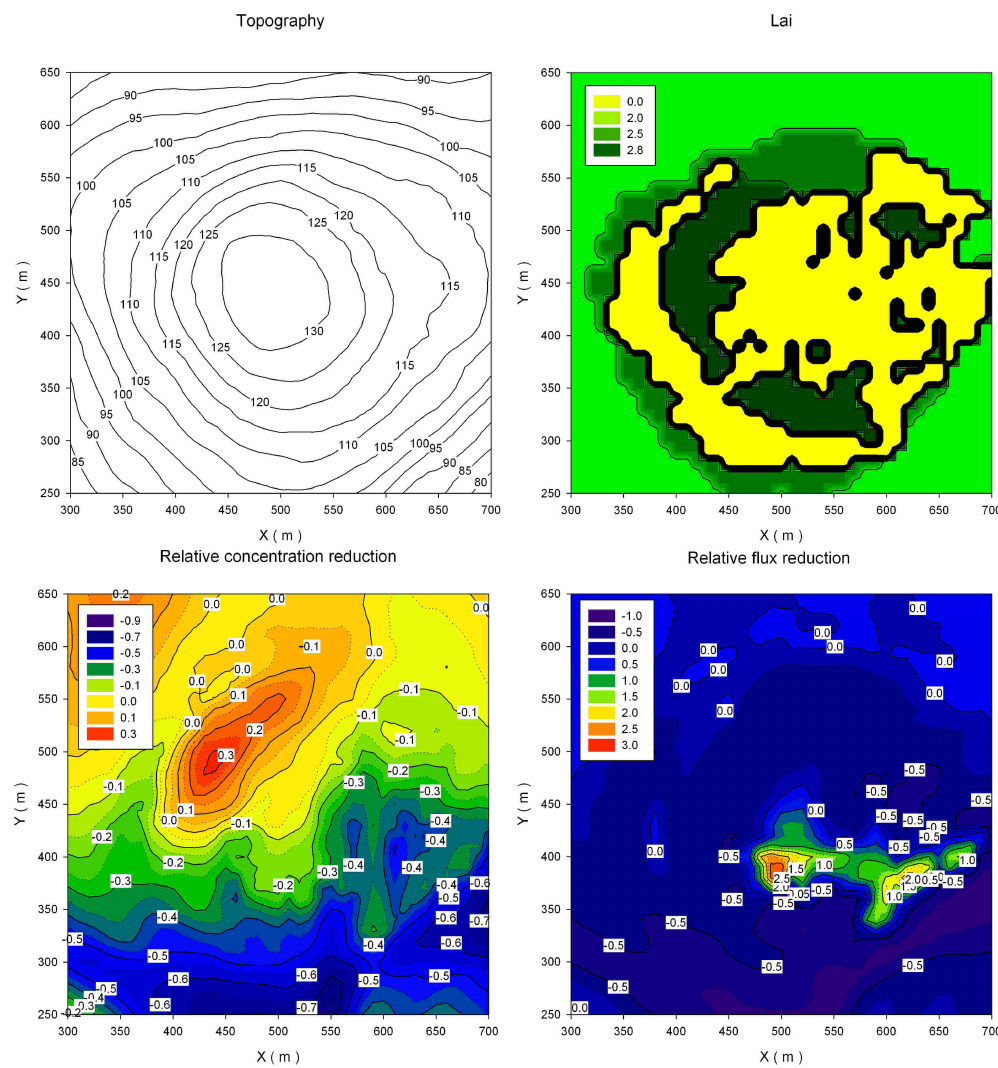
Figure 3. Exemplary relative dilution simulation of a passive scalar at the height of 4m for a southward wind direction (0 ◦ ). The figures display: (top, left) the topography, (top right) the leaf area index distribution, (bottom left) concentration difference scaled to the concentration at the forest edge and (bottom right) relative trace gas flux reduction (Eq. 4, see Fig. 2). The measurement container for gases and some aerosol parameters at the hill top is located at (480m, 430m). Further plots can be found in